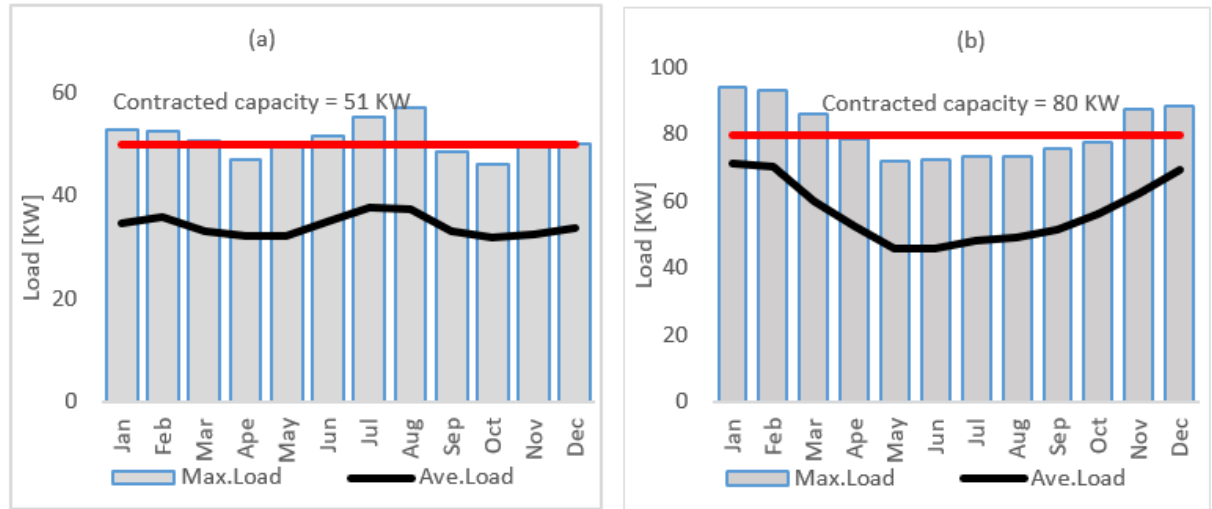
Figure 5. Consumed load and contracted capacity ( a ) for customer C22a and ( b ) customer C22b.